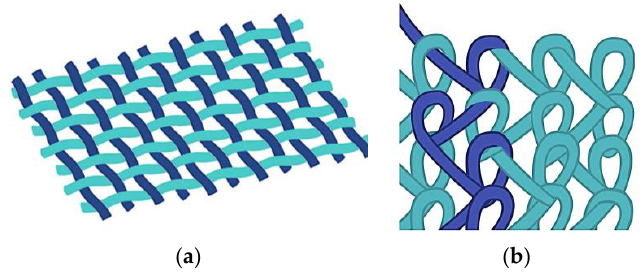
Figure 1. Schematic of: ( a ) woven; and ( b ) warp knitted structures.